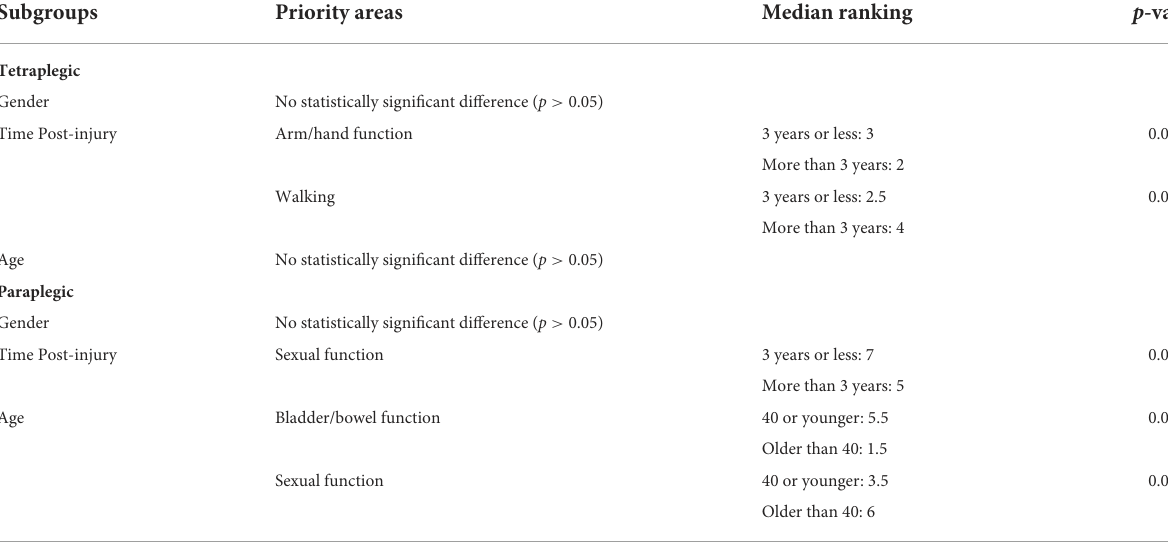
TABLE 5 Summary of statistical findings in tetraplegic and paraplegic according to gender, time post-injury, and